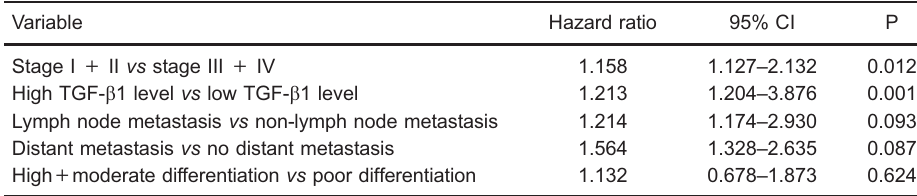
Table 1. Prognostic factors in multivariate